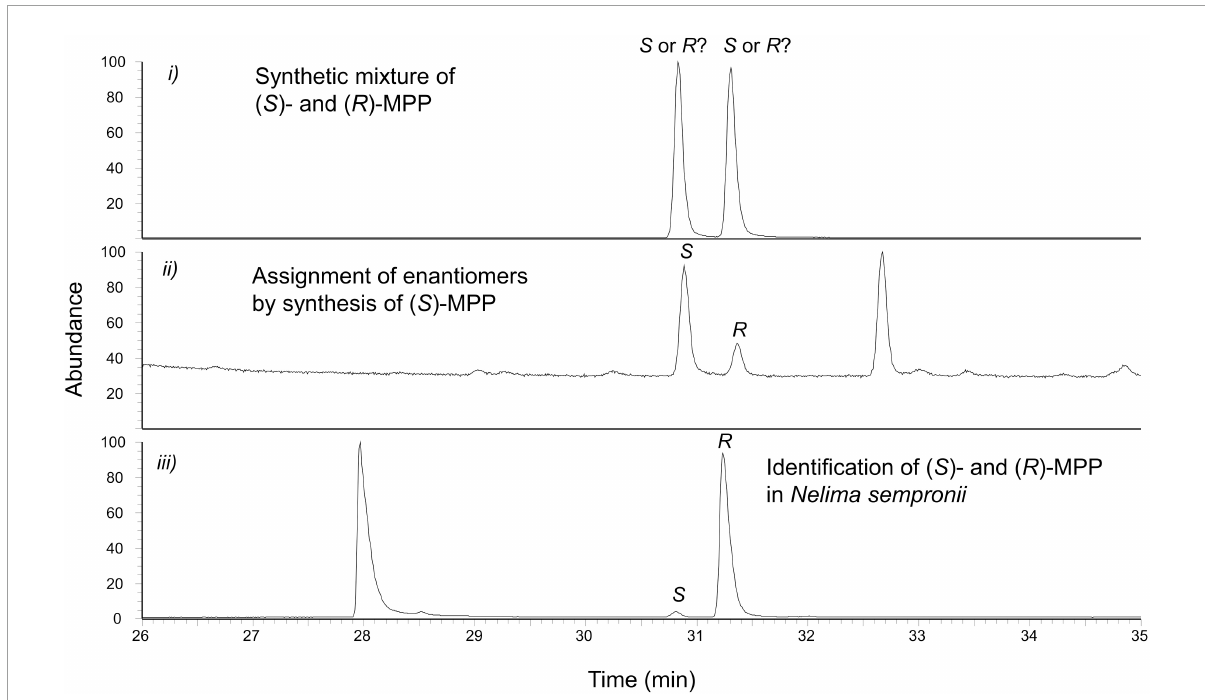
FIGURE5 Absolute configuration of 2-methyl-1-phenyl-pentan-3-one (MPP, compound E) in the extracts of Nelima sempronii . Identification of (2 R )-2-methyl-1-phenyl-pentan-3-one ( R -MPP) using a chiral